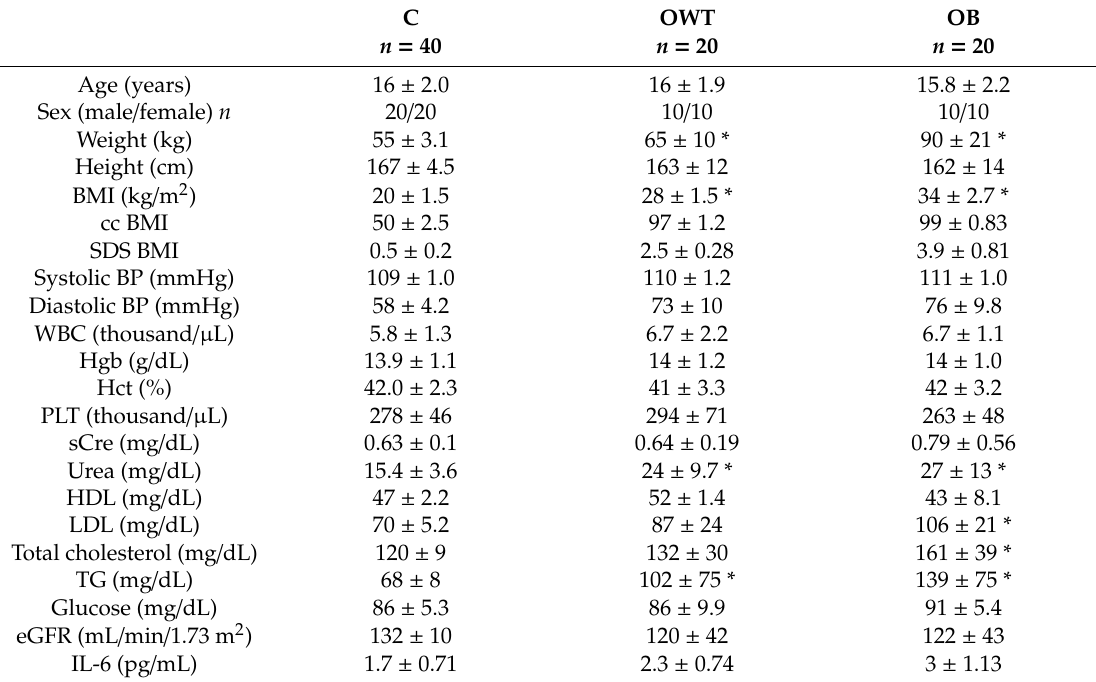
Table 1. Clinical characteristics of patients and healthy